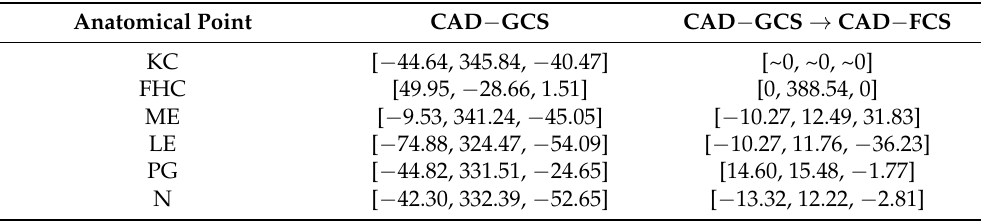
Table 1. Anatomical points marked on CAD model in Solidworks. Anatomical